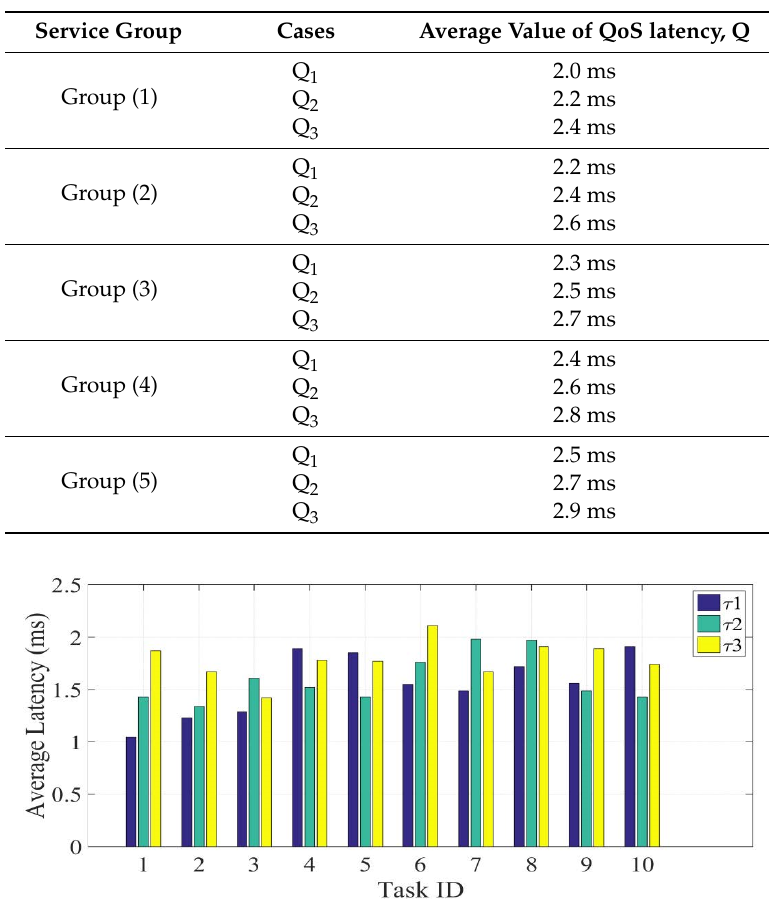
Table 7. Quality of service (QoS) latency of the considered tasks.